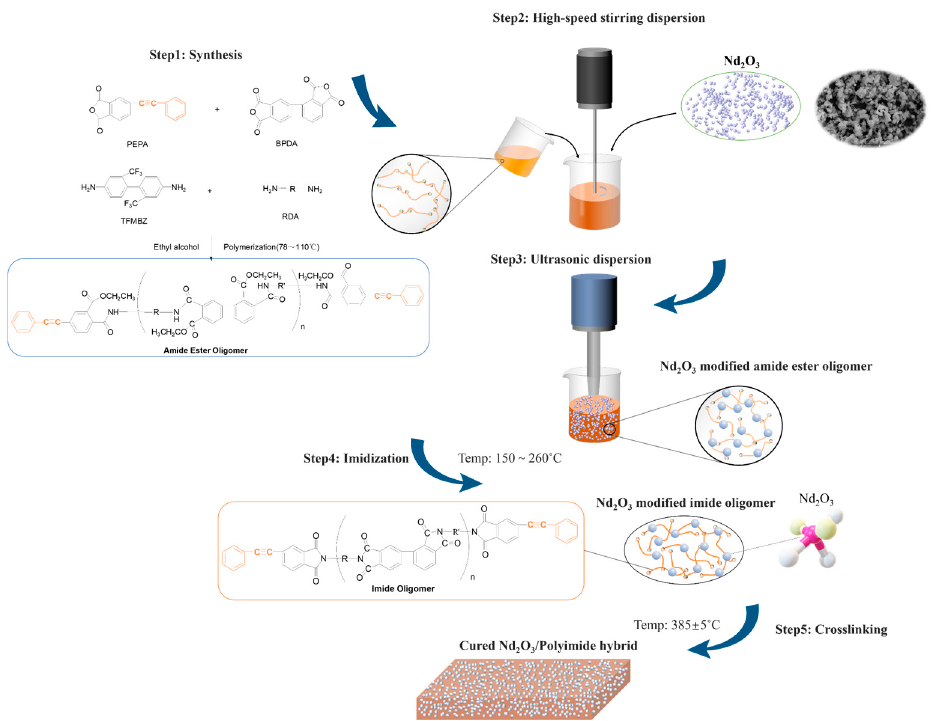
Figure 2. Schematic drawing of the preparation process of the modified polyimide.